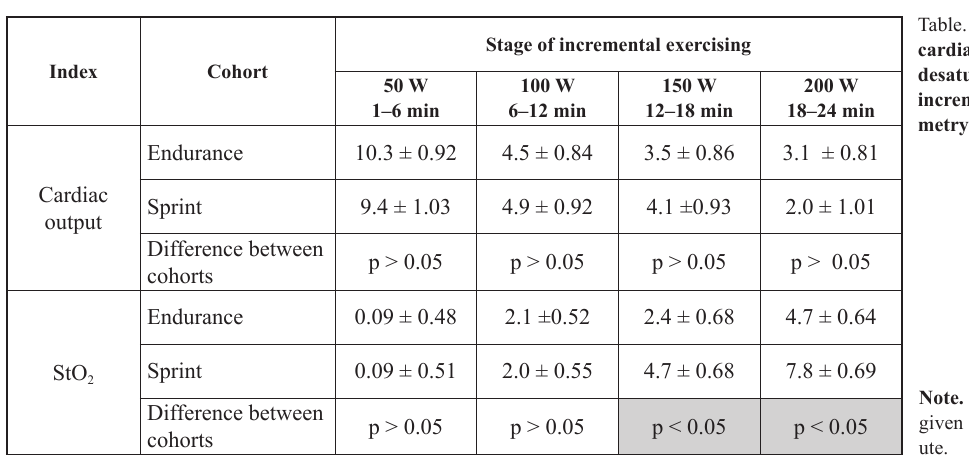
Table. Velocity of changes of cardiac output and